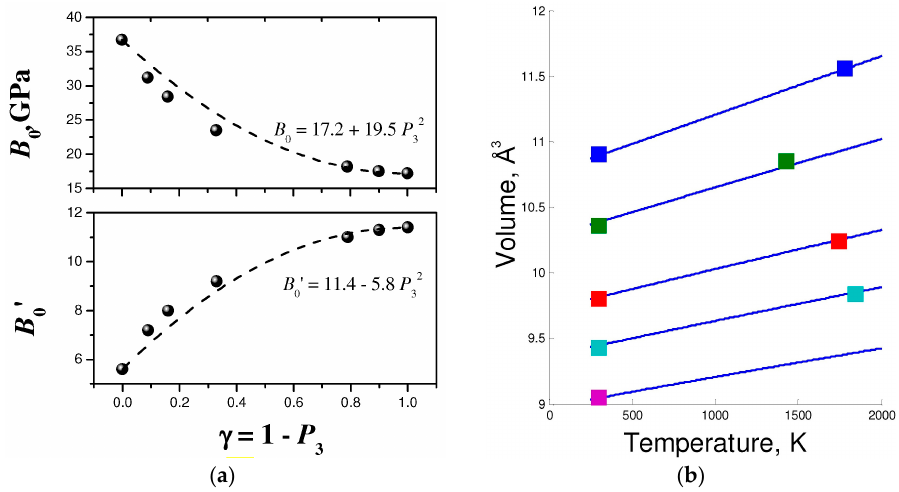
Figure 5. Equations of state of layered BN forms: ( a ) Bulk moduli and their pressure derivatives as a function of structural disorder along c -axis [58]; dashed lines show the model with only P 32 term by analogy to lattice parameter dependence (Figure 2b); and ( b ) isobars (from top to bottom: 0.1 MPa, 2 GPa, 5.2 GPa, 8 GPa and 12 GPa) for hBN, experimental data from [59], adjusted to the p-V-T EOS.